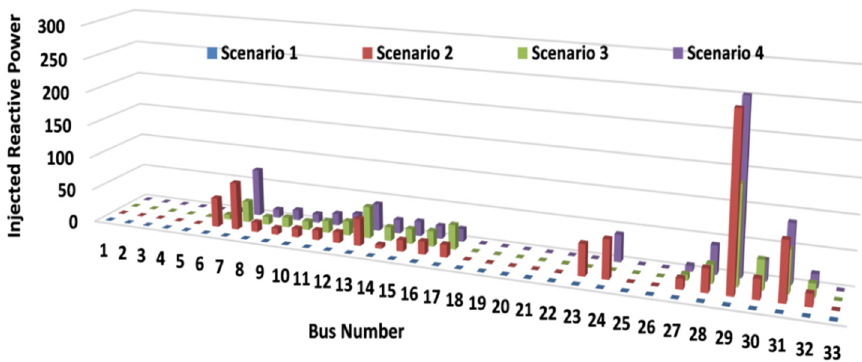
Figure 8. Reactive power injections of DERs.